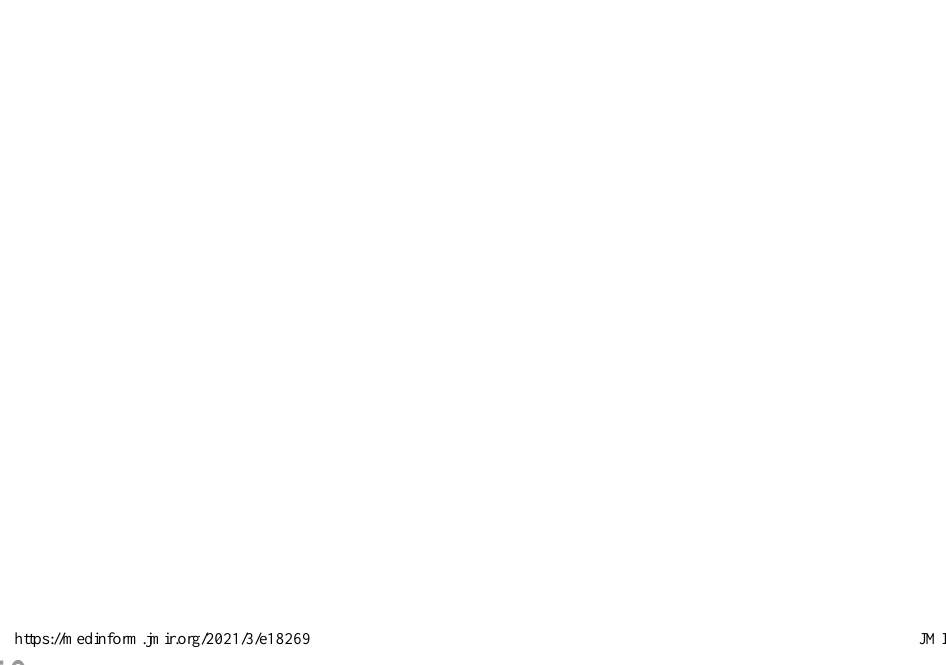
Table 4. Correlation between test-retest in individual items and subscale (Spearman ρ and Kendall τ analysis). Disease-Related Symptoms Subscale – Physical